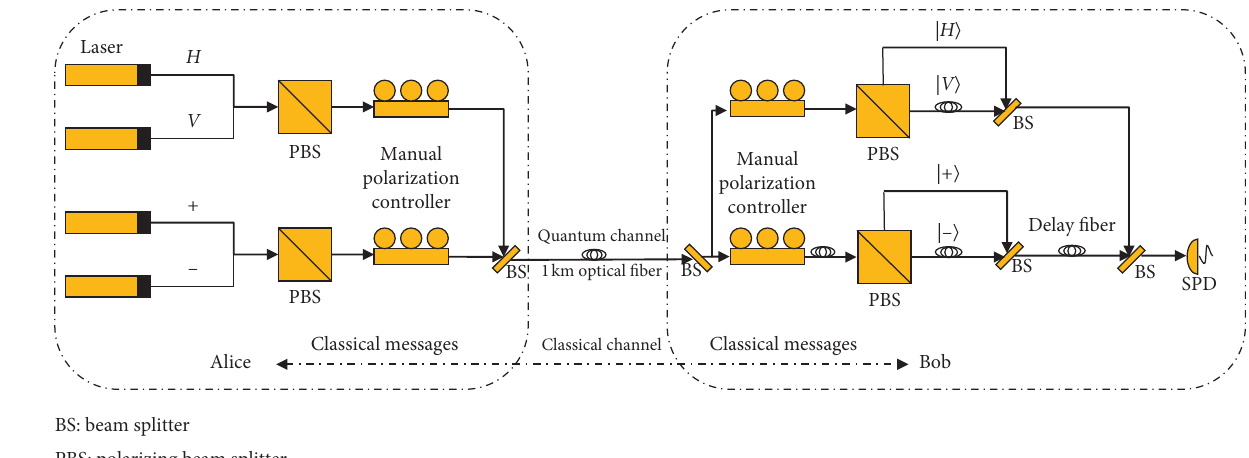
Figure 3: The optical setup of the physical